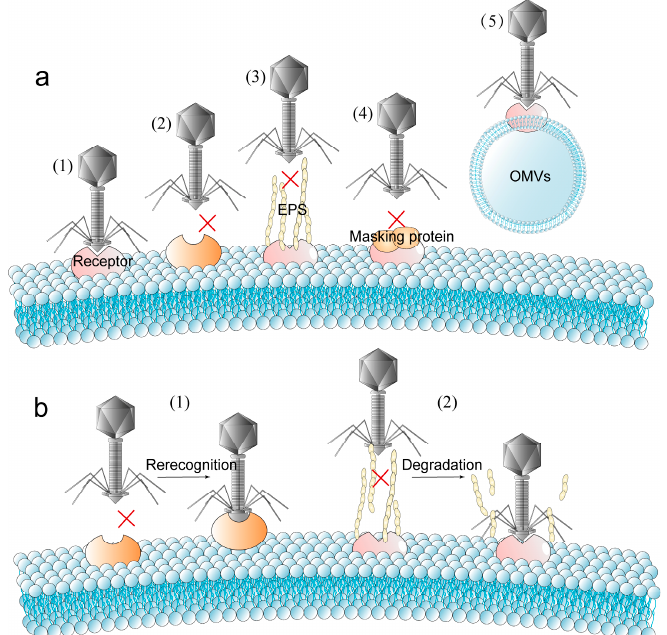
Figure 1. The arms race between bacteria and phages during the adsorption phase (the symbol red crosses in the figure indicate that the phage adsorption is blocked). ( a ) Under normal conditions, phages adsorb to host cells via bacterial surface receptors (1). Bacteria hinder the phage adsorption process by altering the receptor structure or by making the receptor unexpressed (2), by forming extracellular polymeric substances (EPS) (3), by masking proteins (4), or by masking the phage receptors by outer membrane vesicles (OMVs) with phage receptors (5). ( b ) The phages regain the ability to recognize and adsorb the host by recognizing new receptors through mutant receptor binding proteins (RBPs) (1) or by degrading EPS through polysaccharide depolymerases (2). The cell wall is usually thought to protect bacteria from environmental threats [22].